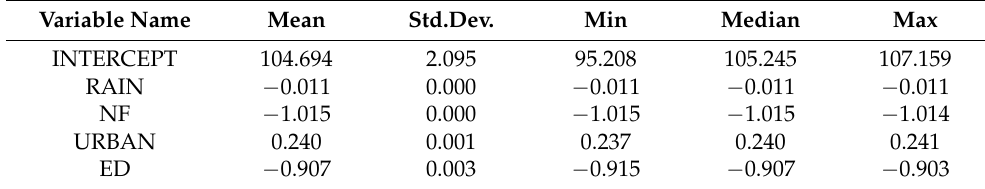
Table 5. Statistical description of the MGWR model coefficient for male groups.